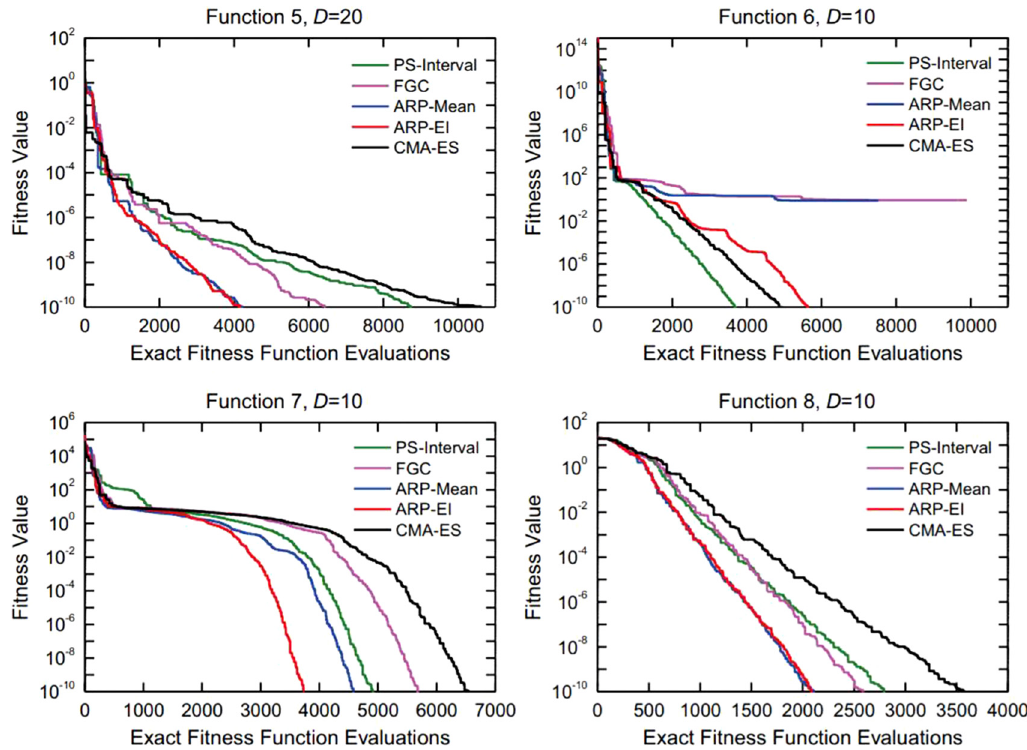
Fig. 2. Convergence graphs of f 5 – f 8